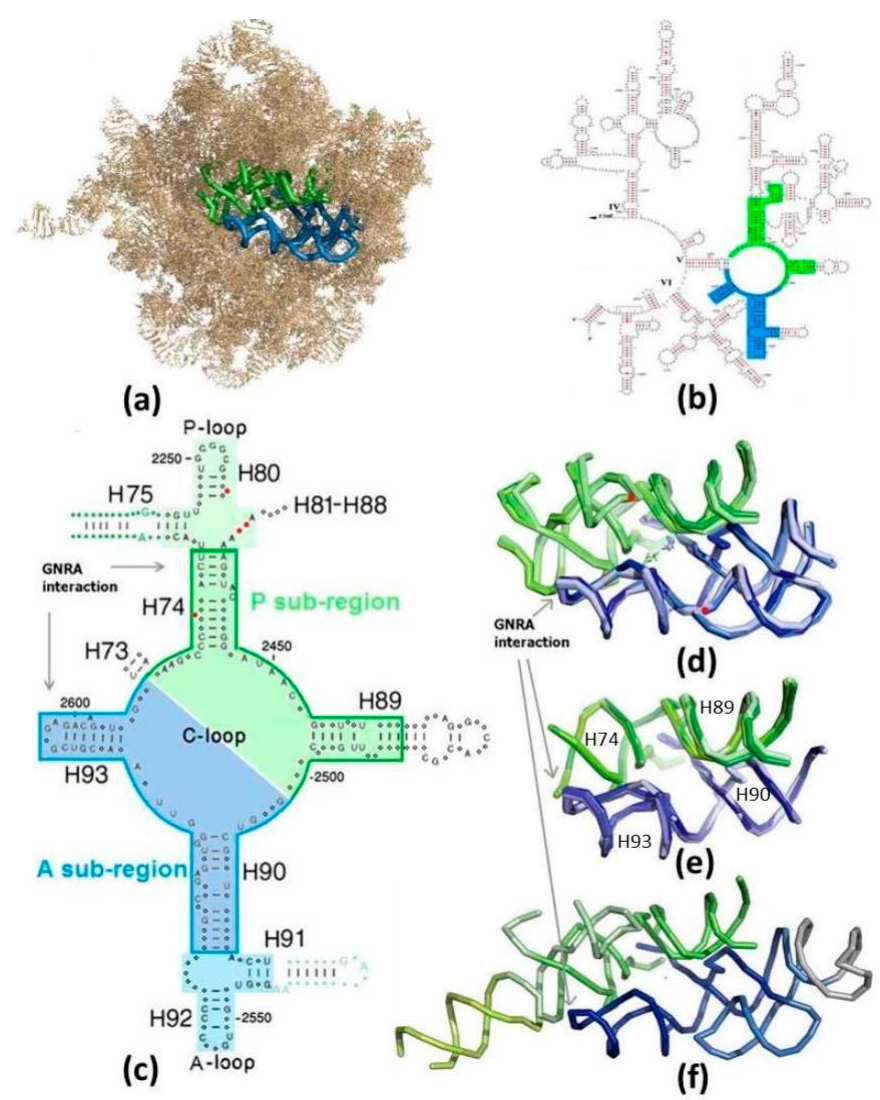
Figure 1. The suggested proto-ribosomes: ( a ) The symmetrical region (SymR) within the 23S ribosomal RNA (rRNA) of E. coli large subunit (pdb 2AW4). A-sub-region in blue, P-sub-region in green (color code maintained in all figures). H68-H71 were removed to expose the SymR; ( b ) The SymR within the secondary scheme of the 3’ half of 23S RNA from E. coli [25], drawn in a manner not portraying the symmetry; ( c ) 2D scheme of the zone encircling the PTC, drawn in a manner exhibiting the symmetry. Nucleotides conserved by more than 97% in each of the three domains of life are indicated by capital letters. Indels are marked by red dots. The core of the SymR, suggested to be the remnant of the dimeric proto-ribosome (DPR, boundary marked), together with the A-, P-sites (on lighter background), compose the SymR. The non-symmetrical parts of H75 and H91, indicated by blue and green letters and dots, extend from the SymR, together forming the ext-SymR; ( d ) Overlap of the SymR fold, with the PTC at its heart, projected along the symmetry axis, as found in the high resolution structures of archaea (pdb 1VQ6), three bacteria (T50S, pdb 2WDL; D50S, pdb 2ZJR; E. coli , pdb 2AW4) and eukarya ( S. cer , pdb 3U5D), together with the reacting amino acid analogs (pdb 2WDL, 1VQ6). Nucleotides G2553 ( E. coli numbering throughout the text) from the A-loop and G2251 from the P-loop, which symmetrically base-pair to C75 of the modern A-, P-tRNA substrates, are indicated by red dots. Peptide bond is formed at the bottom of the cavity; ( e ) The overlap of the DPR folds (same pdb files as in ( d )); ( f ) The fold of the extended symmetrical region (ext-SymR, pdb 2AW4). The dimeric proto-ribosome is drawn in darker hue, the A-, P-sites in lighter hues and the non-symmetrical extensions of H75 and H91 in lime and grey, respectively.